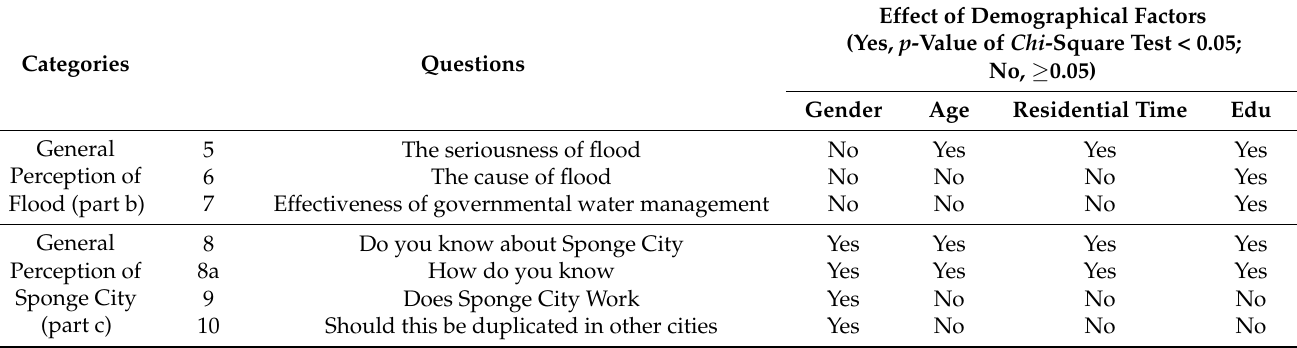
Table 3. The effects of demographic factors on interviewees’